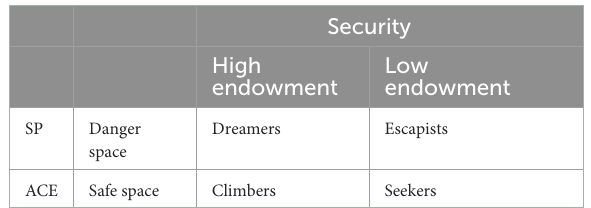
TABLE 1 Four archetypes of migrants by sexuality across space and